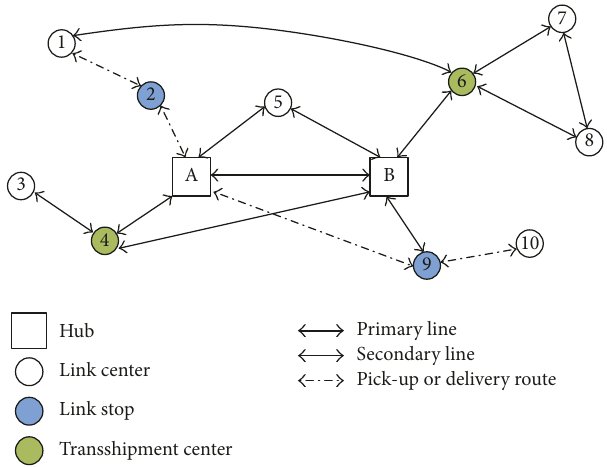
Figure 1: Example of HPTB-EPS network with hub-and-spoke